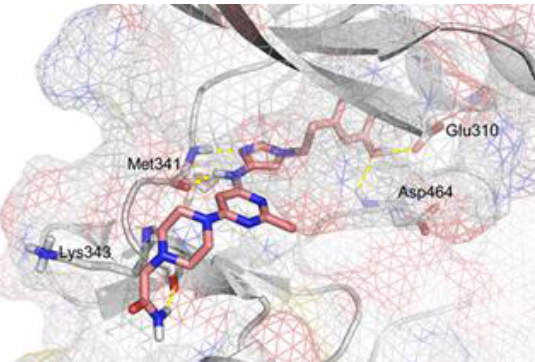
Figure 5. Docking pose of 4j (pink sticks) in the ATP-binding site of c-Src. Hydrogen bonds are shown as yellow dashes. Table 1. NCEs activities and docking scores.